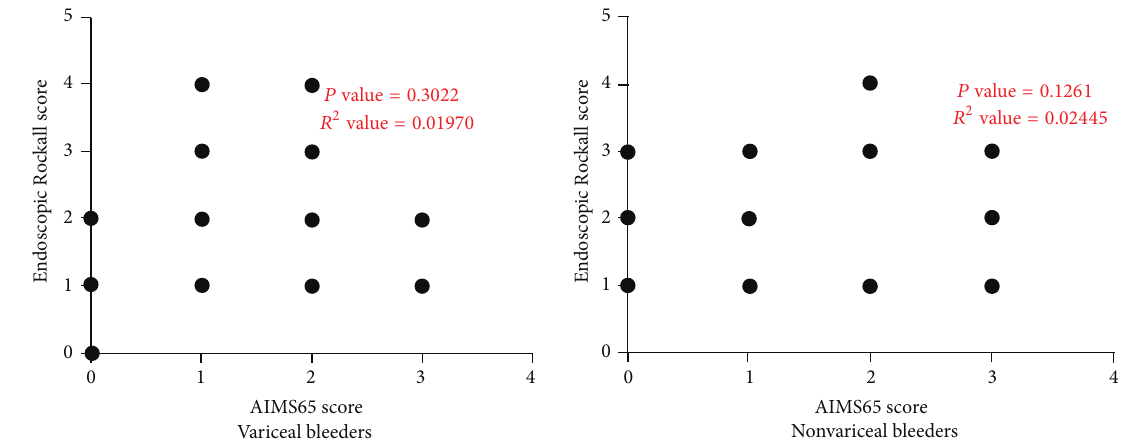
Figure 5: No significant correlation was found between Endoscopic Rockall scores and AIMS65 scores in both cirrhotic variceal ( P value = 0.3022) and nonvariceal bleeders ( P value = 0.1261).